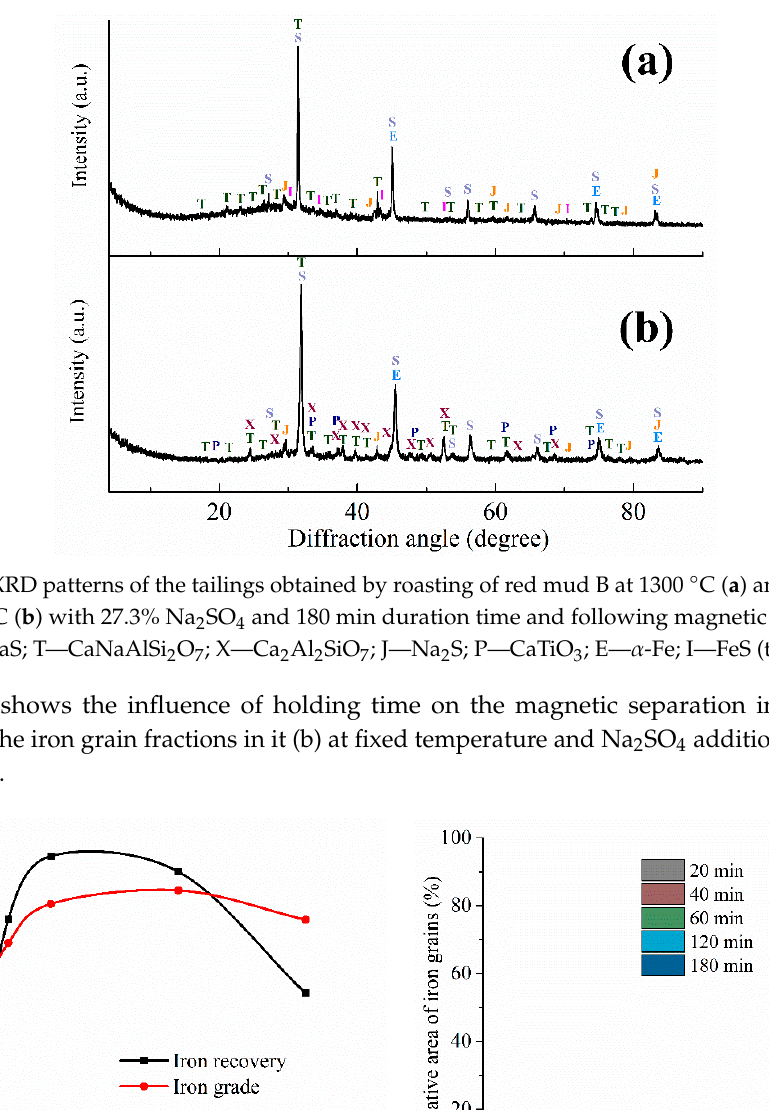
Figure 11. Effect of the Na 2 SO 4 addition to the red mud sample B roasted at 1250–1300 °C during 180 min on iron recovery and grade of magnetic concentrate.